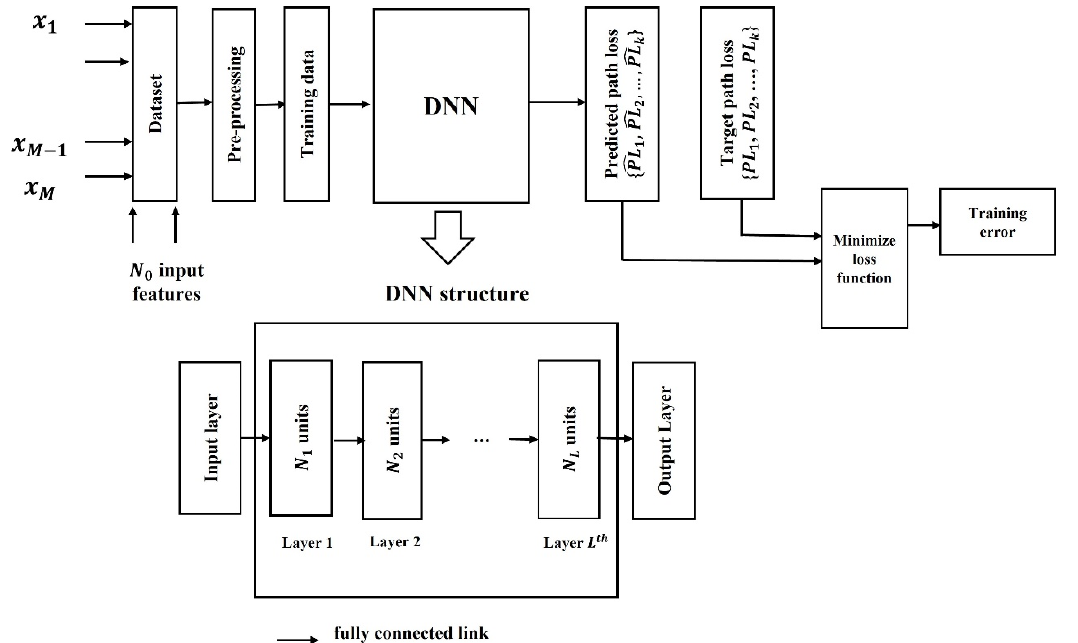
Figure 1. The process of training path loss dataset with the proposed DNN model.